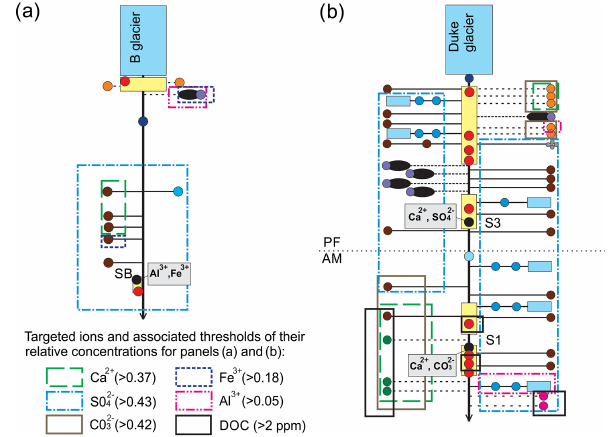
Figure 6. Conceptual maps of ionic content of water samples. Coloured boxes delineate sampled areas with targeted ion relative concentrations above the threshold. The names of sampling points can be found in Fig.